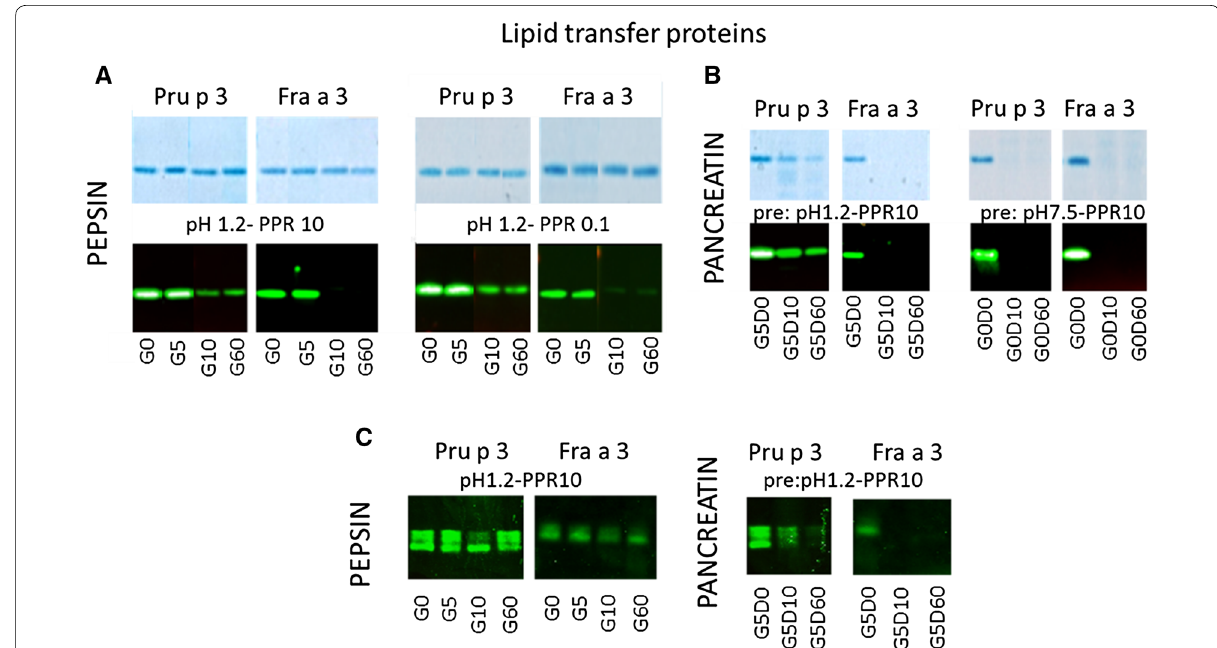
Fig. 2 Selected SDS‑PAGE and immunoblot samples are shown for both LTPs, Pru p 3 and Fra a 3. A Both proteins are highly resistant to pepsin as judged by SDS‑PAGE. In contrast, on immunoblot the intensity of recognition by rabbit IgG clearly decreases at t suggestion that this decrease is more significant for Fra a 3, but it cannot be excluded that this is more a result of properties of the rabbit antiserum than of the proteins. In support of this the G0 band of Pru p 3 is more intense than of Fra a 3. B Both proteins not having been exposed to acidic pH are readily digested by pancreatin. When pre‑exposed to low pH, Pru p 3 displays significantly higher resistance to pancreatin than its homologue Fra a 3. C Also when IgE is used for immunoblotting both LTPs display high resistance to pepsin. The higher resistance of Pru p 3 to pancreatin is also observed with